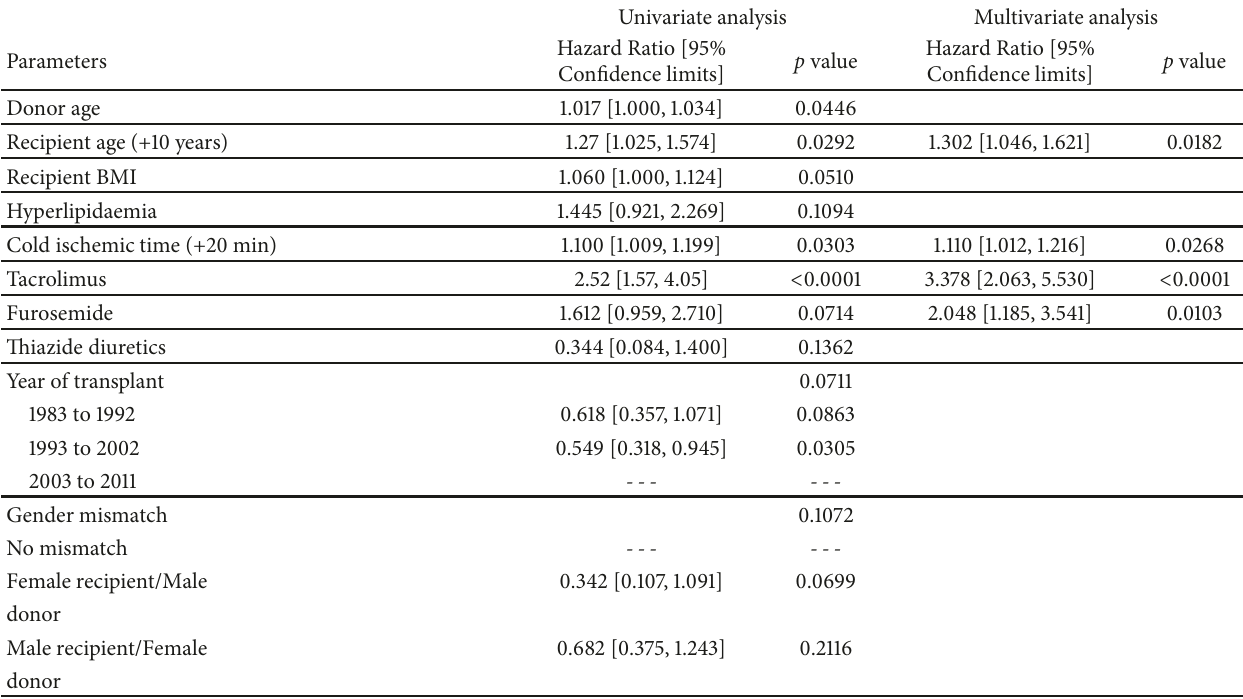
Table 2: Univariate and multivariate analysis for the risk factors related with the development of PTDM at 1 year.